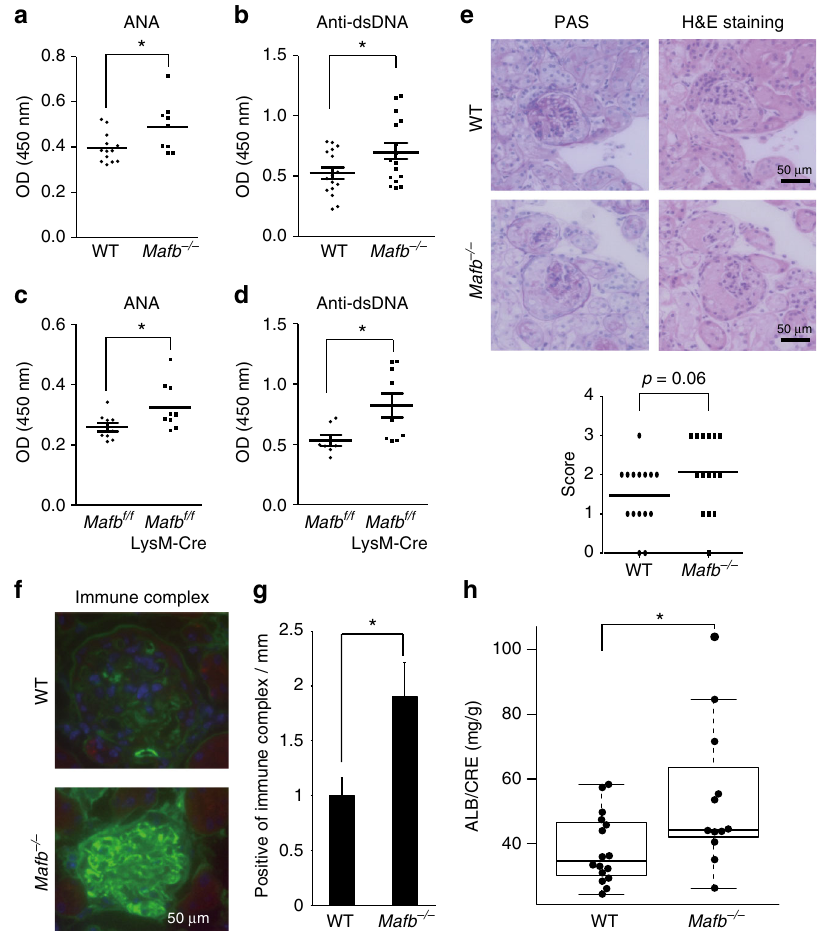
Fig. 6 Mafb − / − mice develop autoimmune disease. a ELISA analysis showed the ANA levels in serum from 6 to 12-month-old transplanted mice (WT, n = 13; Mafb − / − , n = 9). b The production of anti-ds-DNA was observed in serum ( n = 16 for each genotype). c The ANA level of Mafb f/f ::LysM-Cre and Mafb f/f were analyzed by ELISA ( Mafb f/f , n = 9; Mafb f/f ::LysM-Cre, n = 10). d Serum anti-ds-DNA was analyzed by ELISA ( Mafb f/f , n = 7; Mafb f/f ::LysM-Cre, n = 9). a – d The results of duplicate independent experiments were pooled. e Kidneys were stained with PAS and HE staining. Glomerulonephritis was scored from 0 to 3 in a blinded test (WT, n = 16; Mafb − / − , n = 15). The data were analyzed with the Brunner – Munzel test. f The deposition of immune complexes in glomeruli was assayed for the immune complex (IgG + IgM + IgA). g Immune complex-positive glomeruli were quanti fi ed (WT, n = 5; Mafb − / − , n = 5). h Urinary protein was measured in WT and Mafb − / − 12-month-old transplanted mice (WT, n = 17; Mafb − / − , n = 12). The data are presented as the mean ± s.e.m. * p < 0.05 (Welch ’ s t -test). The results of two independent experiments were